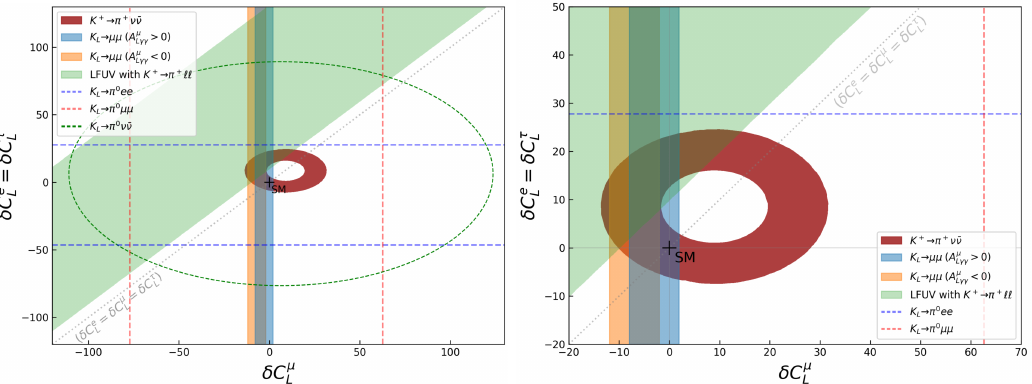
Figure 11 . BR( K + → π + ν ¯ ν ) (left) and BR( K L → π 0 ν ¯ ν ) (right) as a function of δC e and δC µ . In the left plot, the solid (dashed) line corresponds to the measured central value ( 1 σ L experimental uncertainty) by NA62 [15]. In the right the upper bound on BR( K L → π 0 ν ¯ ν ) is not visible for the values scanned.